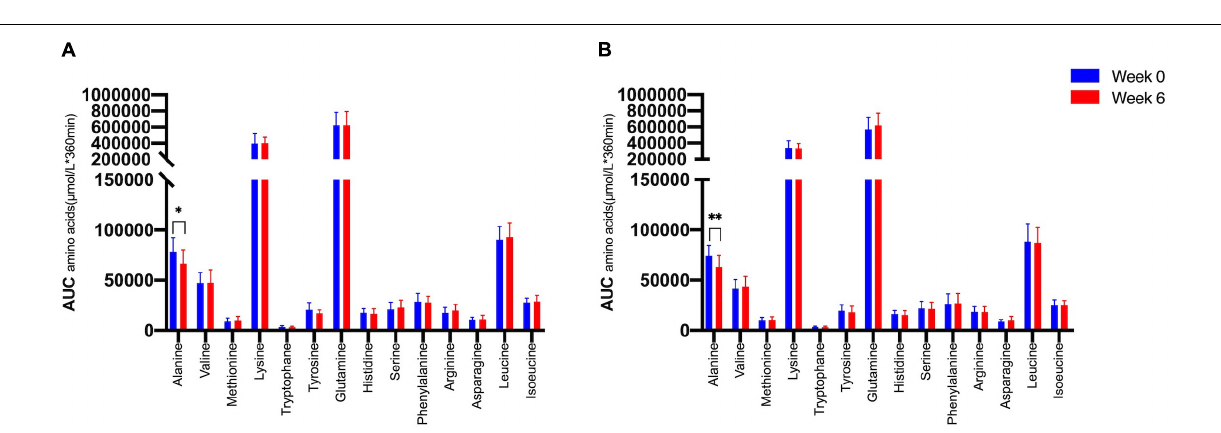
FIGURE 5 | Area under the curve (*360 min) of amino acids in the MMTTs before (Week 0, blue) and after the intervention (Week 6, red). ∗ p < 0.05; ∗∗∗ p < 0.001.